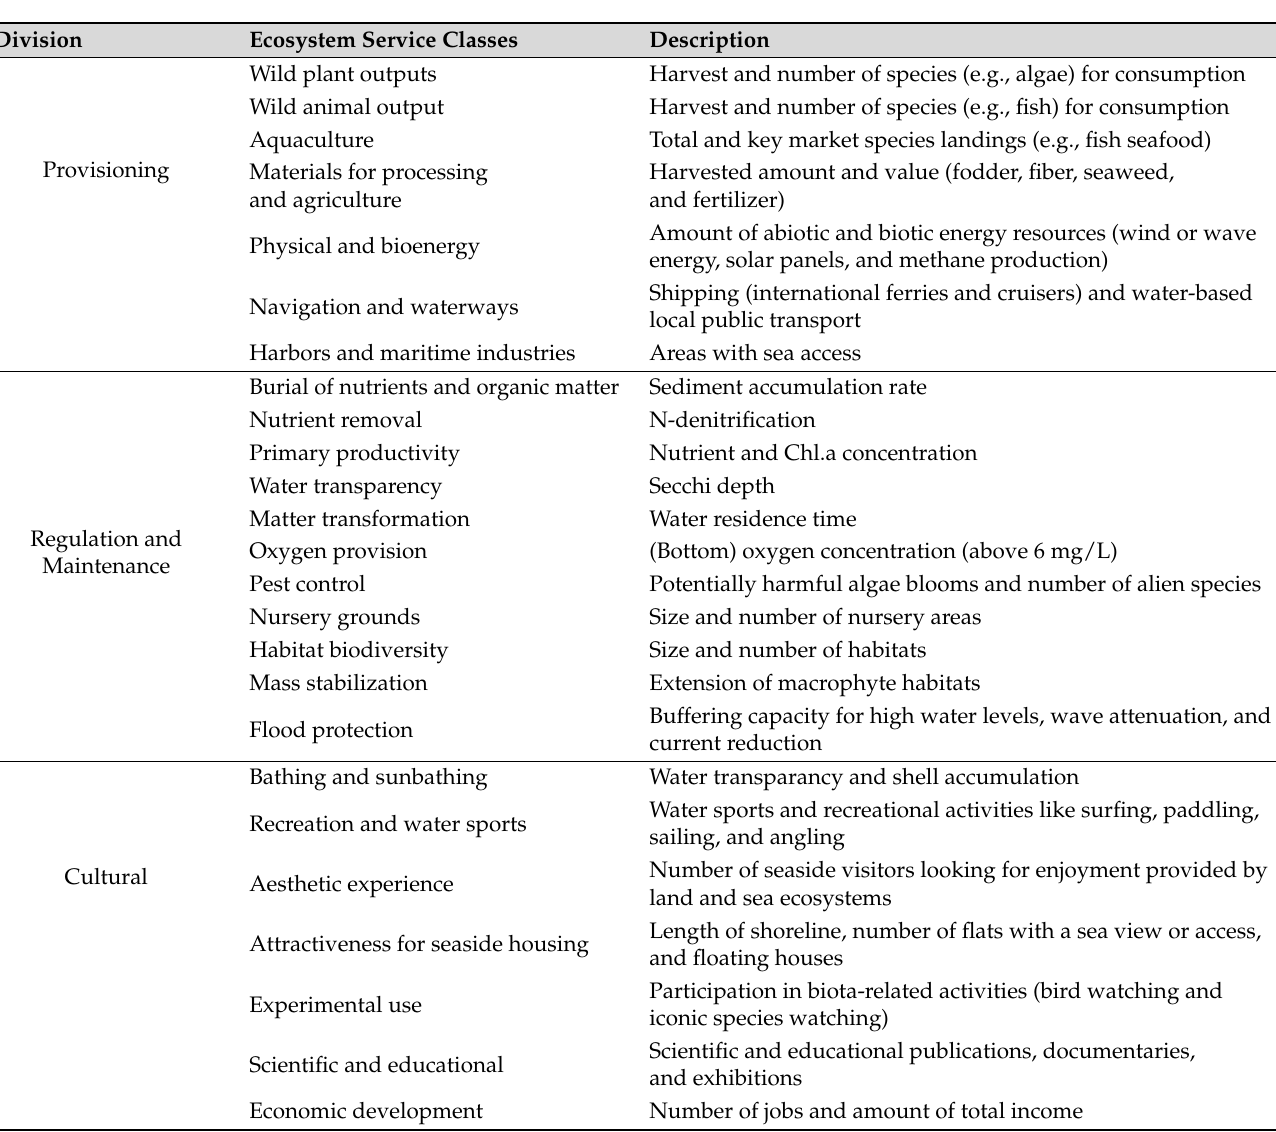
Table 3. Ecosystem service classes and the associated descriptions which were chosen for the ecosystem service